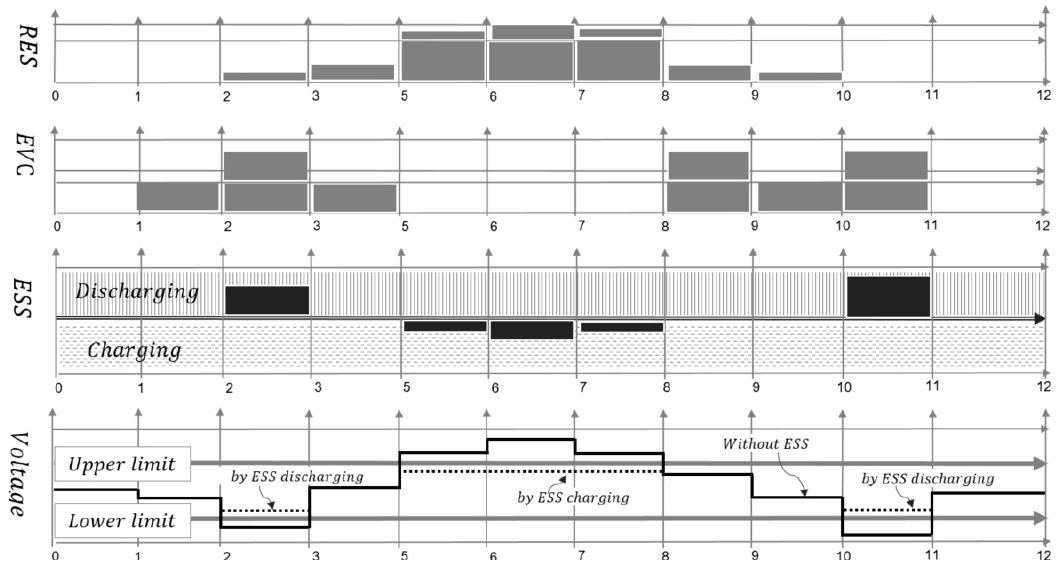
Figure 1. Strategy of power stabilization in the secondary feeder by an energy storage system (ESS).